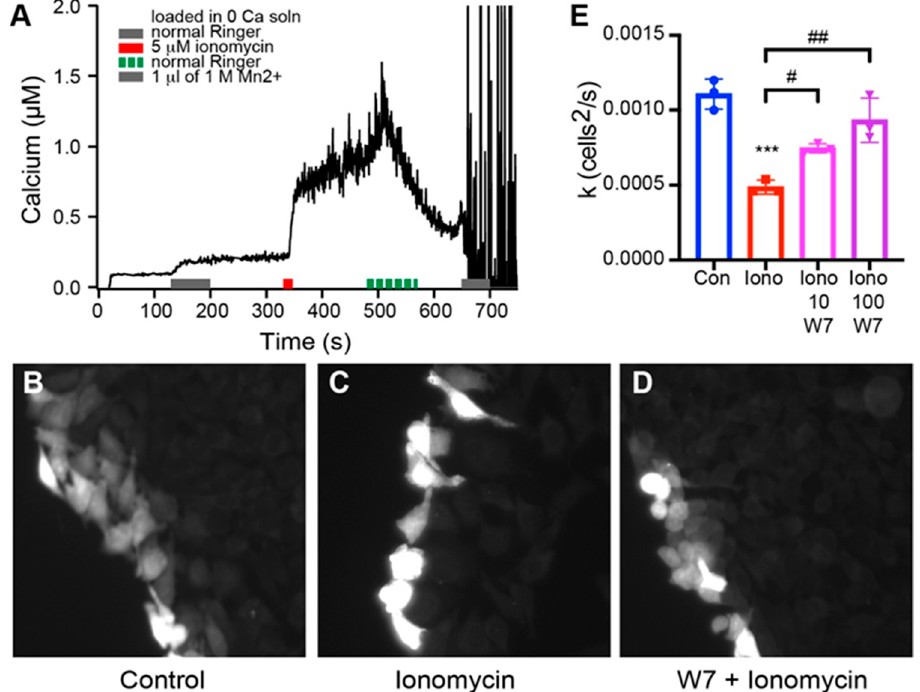
Figure 4. High calcium-induced uncoupling of HeLa cells expressing Cx35. ( A ) Ratiometric Ca 2+ measurement in HeLa cells loaded with Fura-2-AM in zero Ca 2+ Ringer solution. Gray bar indicates solution exchange into normal Ringer with 2.5 mM extracellular Ca 2+ . The red bar indicates solution exchange into normal Ringer containing 5 µM ionomycin; the green dashed bar indicates solution exchange back to normal Ringer. Direct addition of 1 µL 1 M MnCl 2 quenches Fura-2 fluorescence as a control (resulting in the erratic ratiometric Ca 2+ calculation seen in the trace). ( B – D ) Scrape-loading measurement of Neurobiotin tracer coupling in HeLa-Cx35 in normal Ringer ( B ), 5 µM ionomycin ( C ), and 5 µM ionomycin plus 100 µM W7 ( D ). ( E ) Diffusion coefficients (k) for Neurobiotin tracer coupling in HeLa-Cx35 in control, 5 µM ionomycin, and 5 µM ionomycin plus 10 µM or 100 µM W7. Bars are mean ± SD, n = 3 experiments, 5 measurements/experiment; *** p < 0.001 vs. control; # p < 0.05 and ## p < 0.01 vs. 5 µM ionomycin.